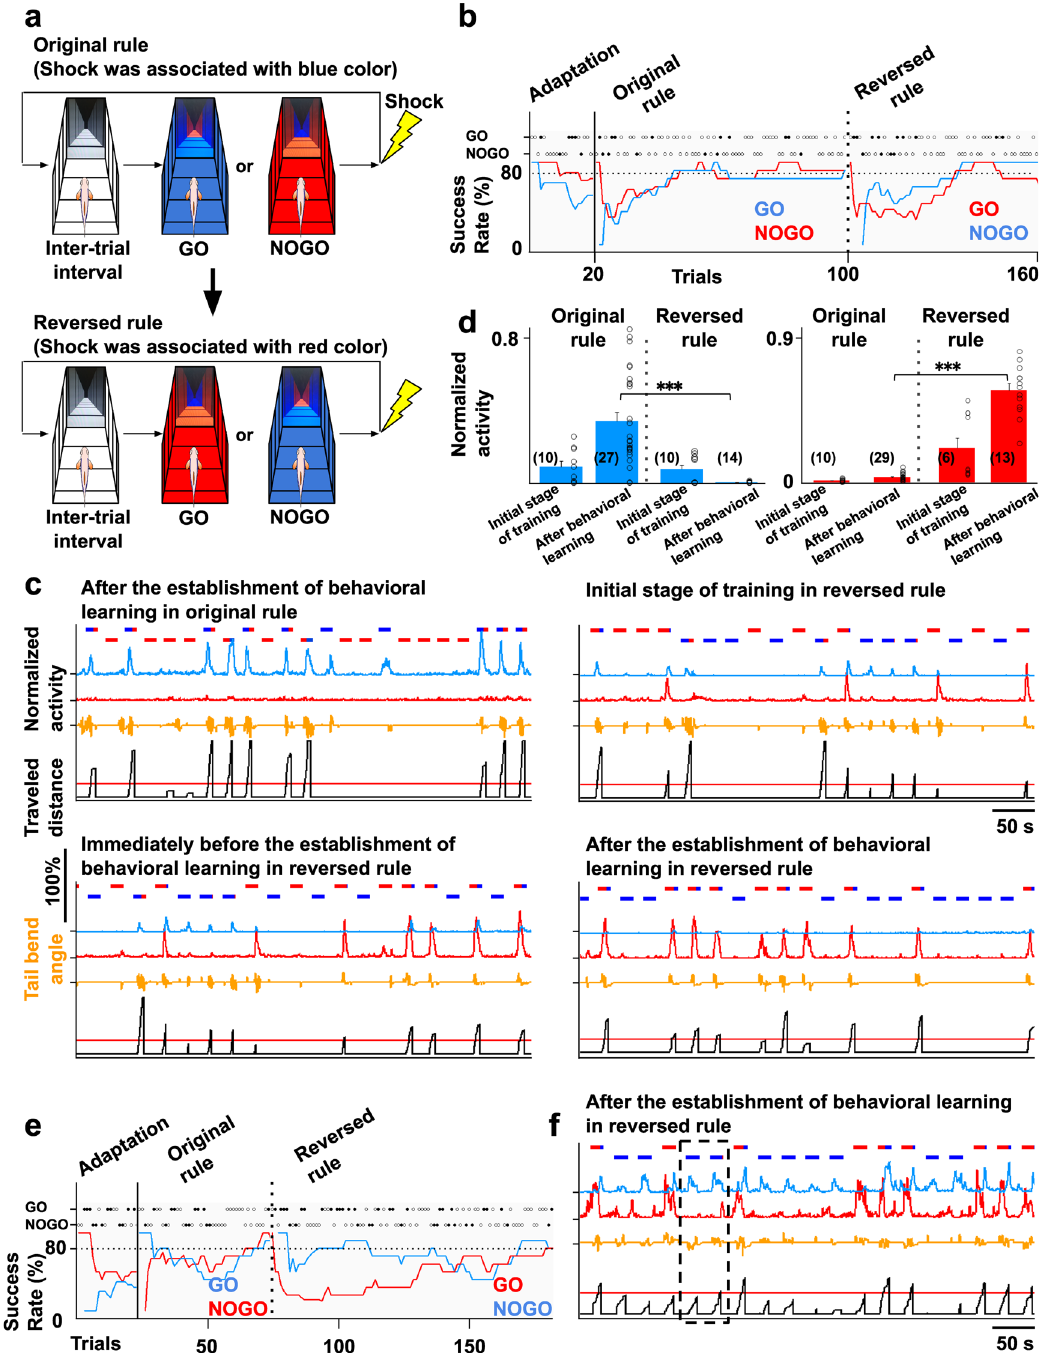
of blue color was not subject to rule